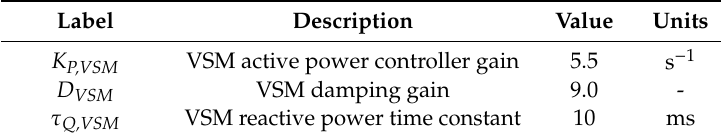
Table 3. Summary of VSM parameters.